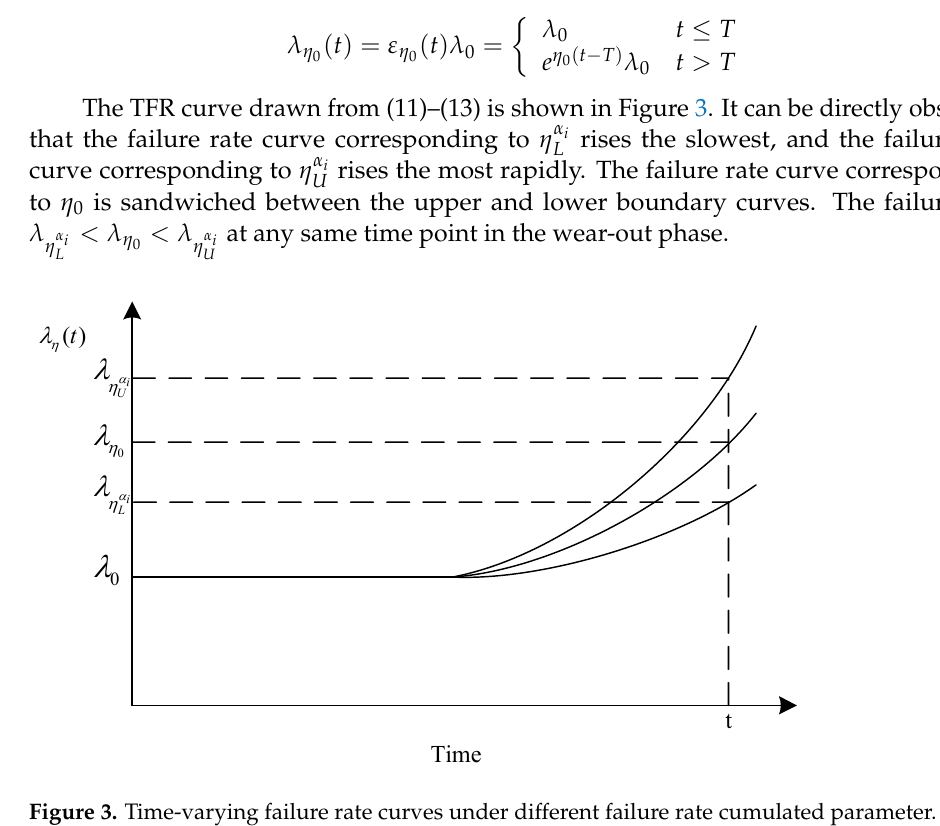
Figure 3. Time-varying failure rate curves under different failure rate cumulated